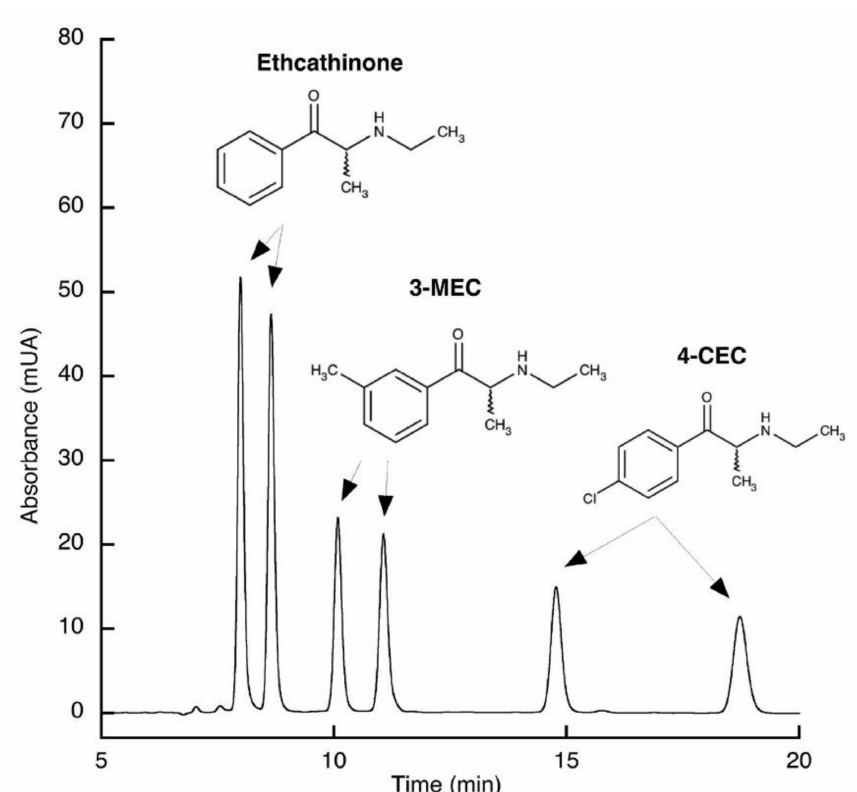
Figure 18. Chiral separation of three different cathinone derivatives (ethcathinone, 3-MEC and 4-CEC) by HPLC-UV